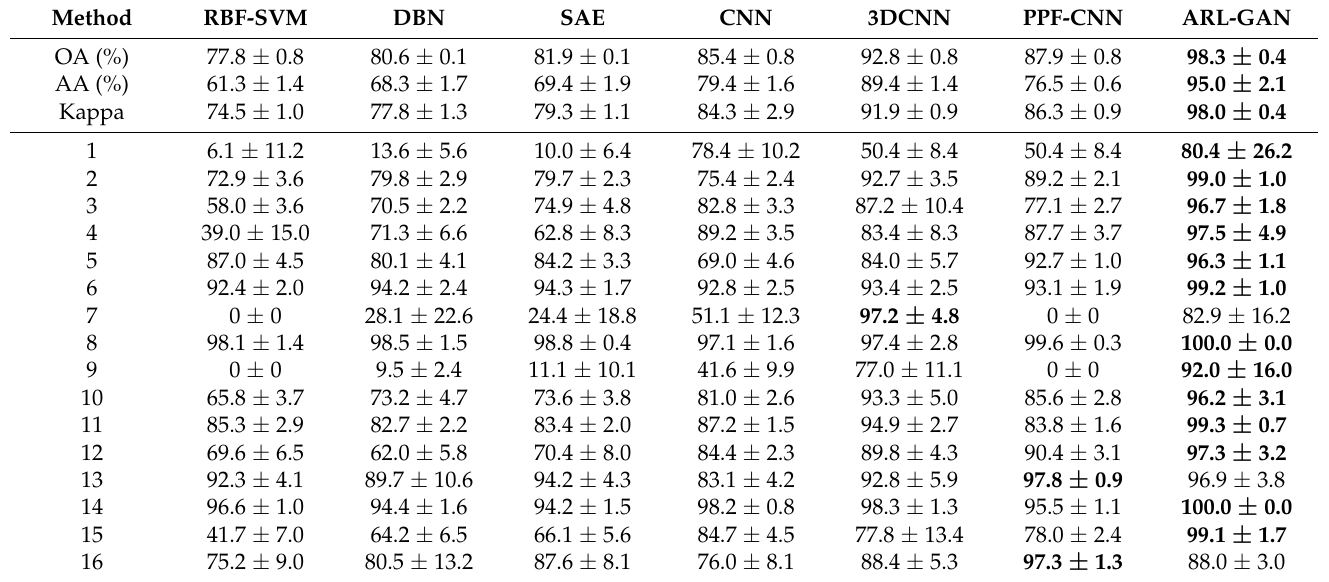
Table 4. Classification comparison result of ARL-GAN with different algorithms on Indian Pines